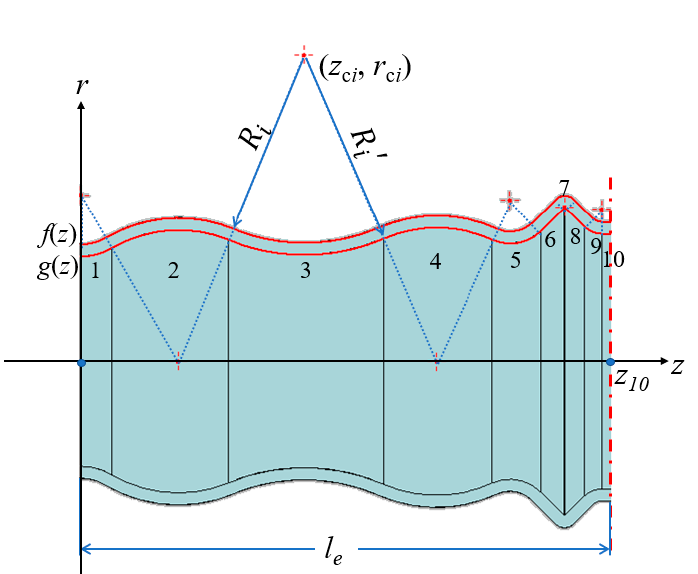
Figure 10. Geometric configurations of formed bellows. (Left-half part).